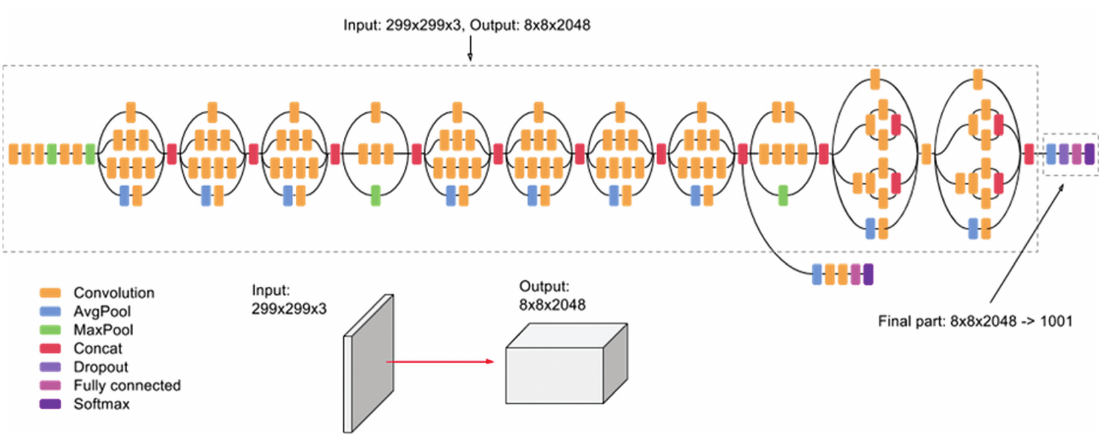
Figure 3: Basic Inception CNN Architecture.